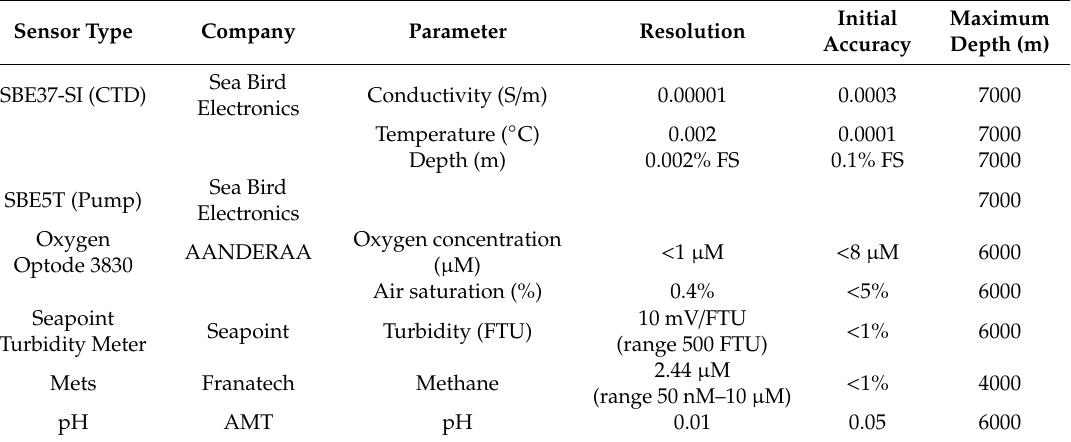
Table 1. Technical specifications of the sensors installed in the Amerigo